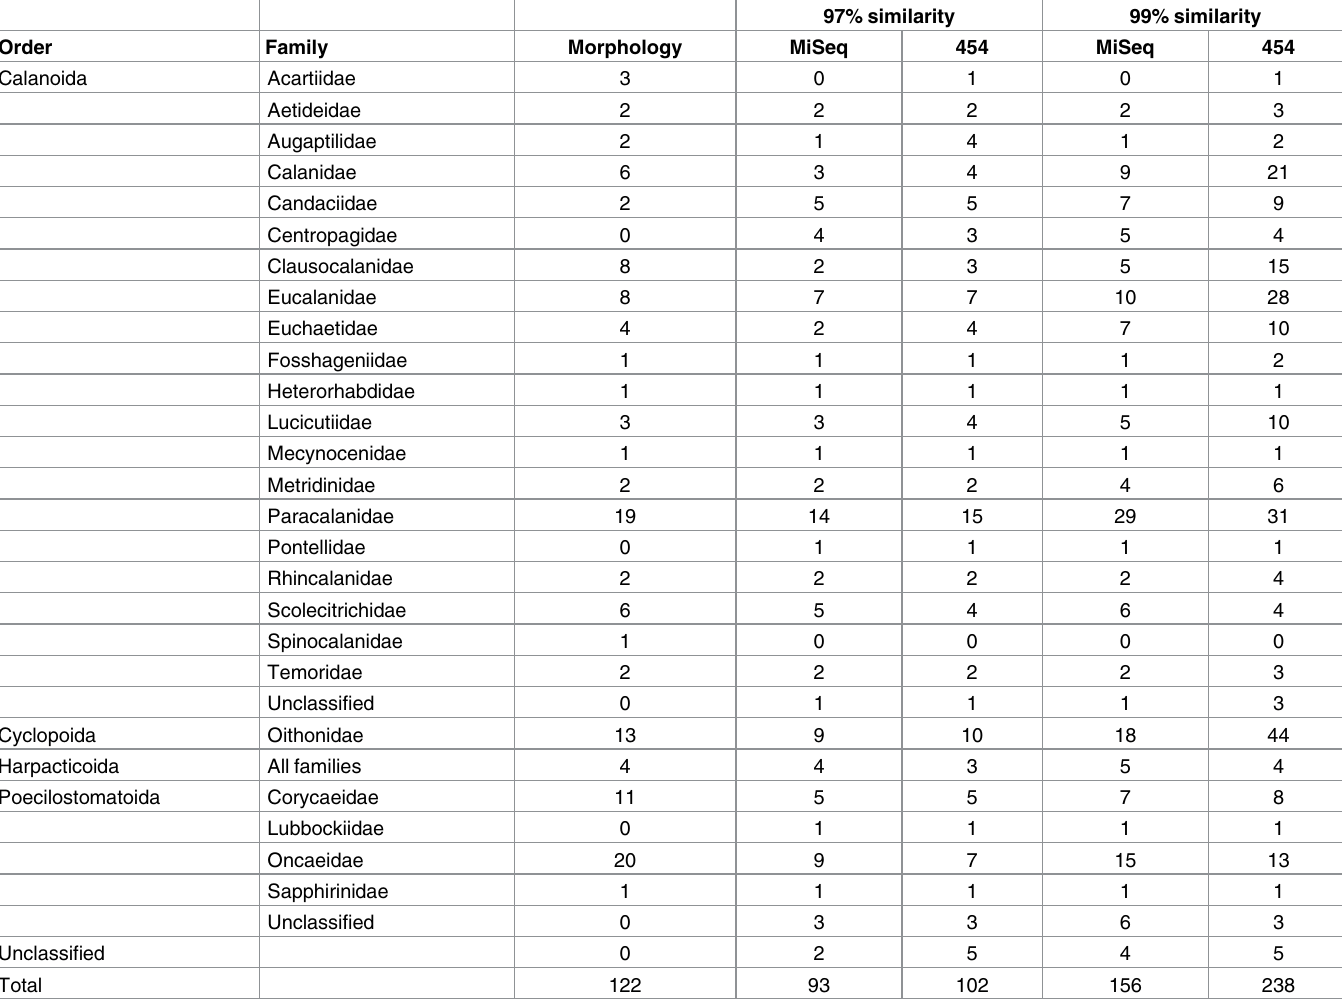
Table 3. Comparison of morphologically classified species and MOTU numbers at 97 and 99% similarity thresholds in field-collected